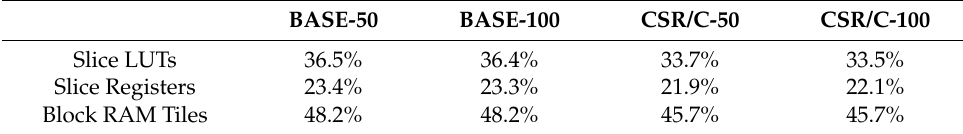
Table 4. The resource utilization of the BASE and CSR/C